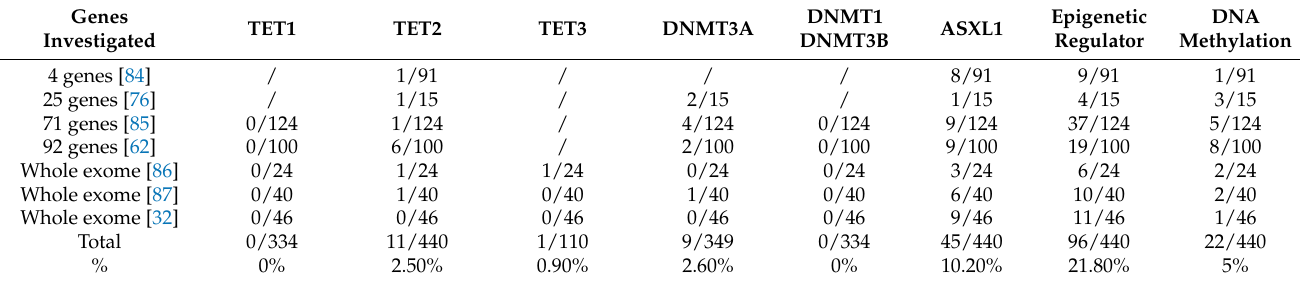
Table 1. Mutation in genes encoding epigenetic regulators at CP-CML diagnosis (relative to the total number of patients under